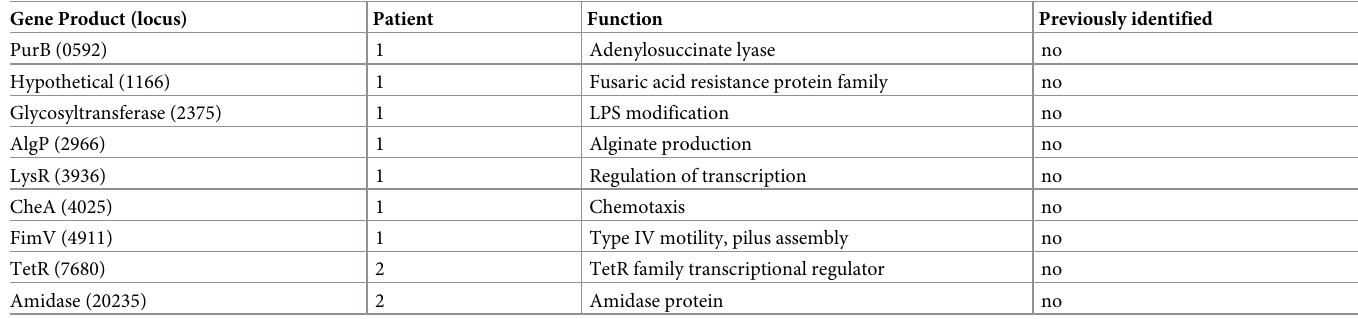
Table 3. Loci with multiple independent mutations in patients 1 and 2. Genes with multiple mutations in the corresponding CDSs of the longitudinal isolates from patient 1 (P1bm2009 –P1Bm2015) and patient 2 (P2Bm2011a, b), see Tables I and K in S1 Tables respectively. These adaptive mutations have not been reported in the B . multivorans literature (Table L in S1 Tables).